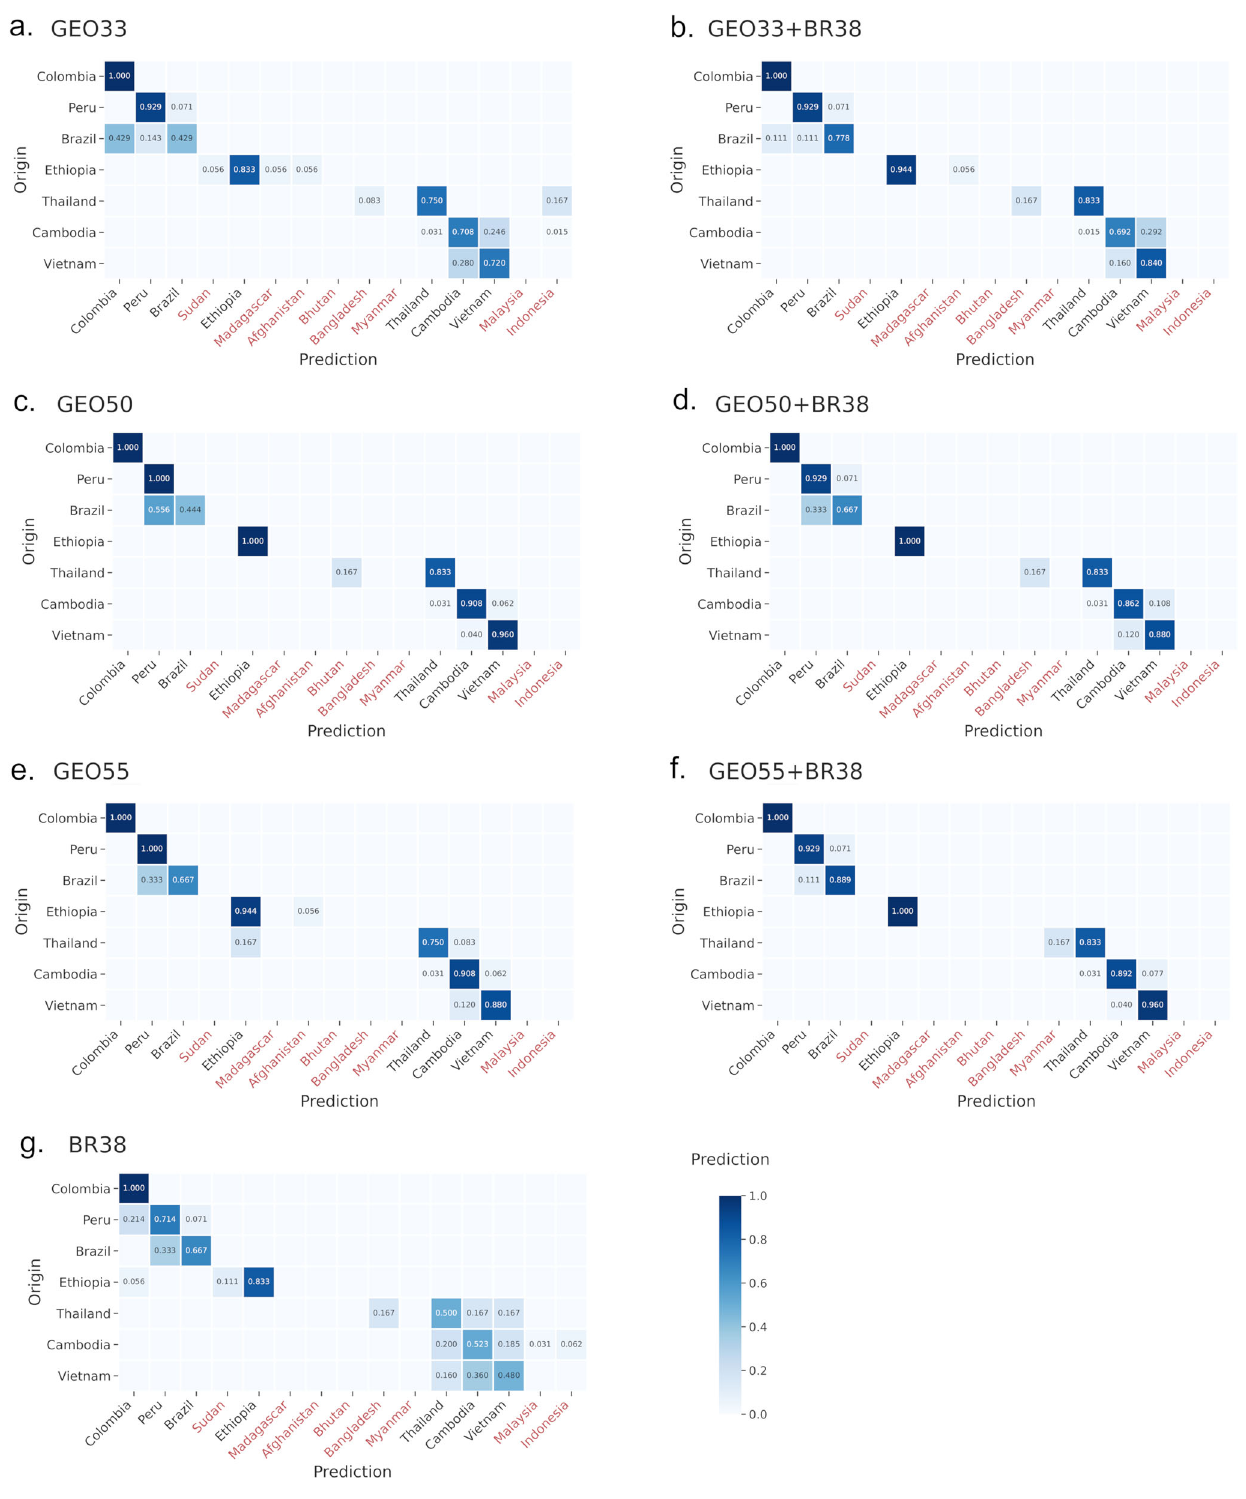
Fig. 4 Heatmap illustrating country prediction accuracy at the BR38 and GEO barcodes in the Independent Validation Dataset. Each plots presents the prediction performance of the given SNP panel (panels a – g ) in the Independent Validation Dataset ( n = 142 biologically independent samples) visualized as a heatmap showing the correlation between country of Origin and Prediction. Each cell is colour-coded to re fl ect the proportion of samples from the given country of Origin that were correctly assigned to the corresponding Prediction country. Colour-coding scaled from light blue (low proportion) to dark blue (high proportion). Only countries that were predicted by at least one of the SNP panels are presented, and Prediction countries that were not represented in the Independent Validation Set (i.e., not on the Origin axis) are labelled in red. Where samples ’ country of Origin did not directly match the country of Prediction, they generally mapped to neighboring countries (i.e., still within the correct regional geography). The BR38 panel exhibited lower prediction accuracy than the GEO and combined GEO + BR38 panels. Across the SNP panels, majority of incorrect predictions occurred between Cambodia, Vietnam and